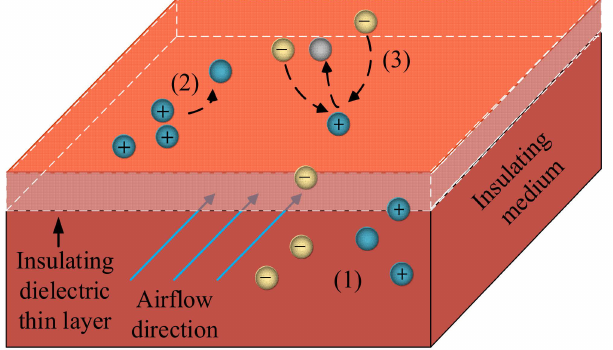
Figure 22. Schematic diagram of the charge dissipation process on the insulating medium surface in an airflow